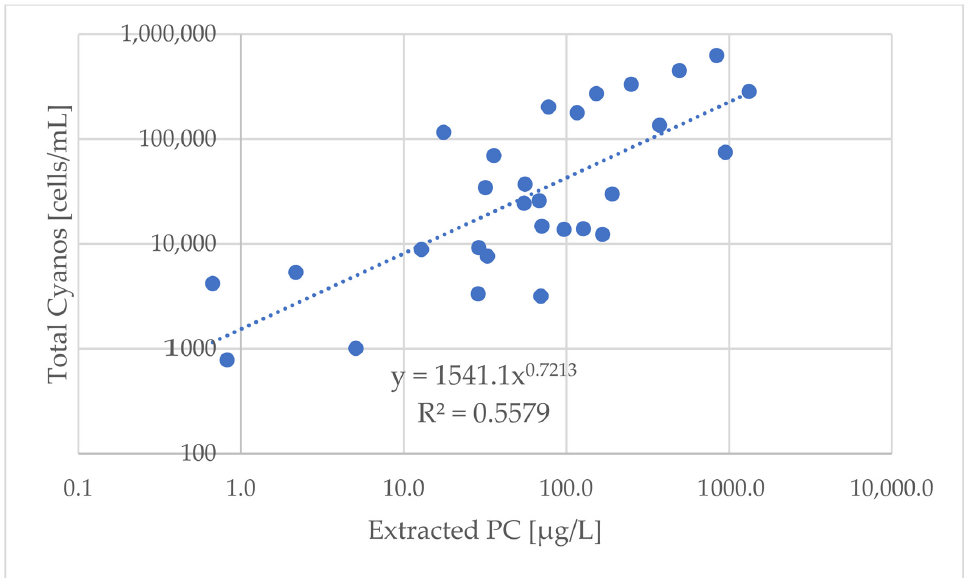
Figure 5. Correlation between extracted phycocyanin and total cell count of cyanobacteria from CIGLR data. (Data source: